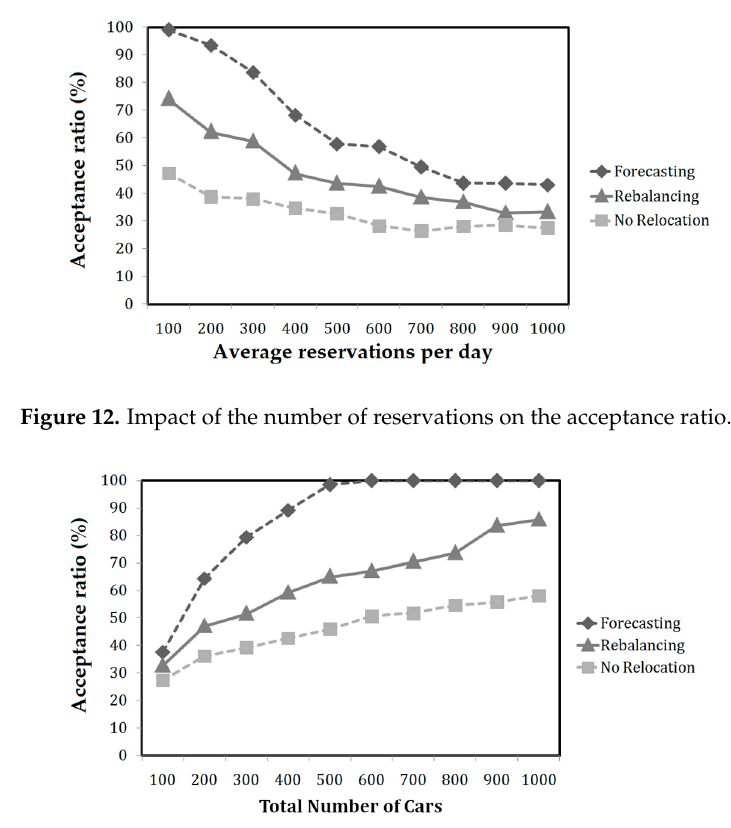
Figure 13. The impact of the number of cars on the acceptance ratio.